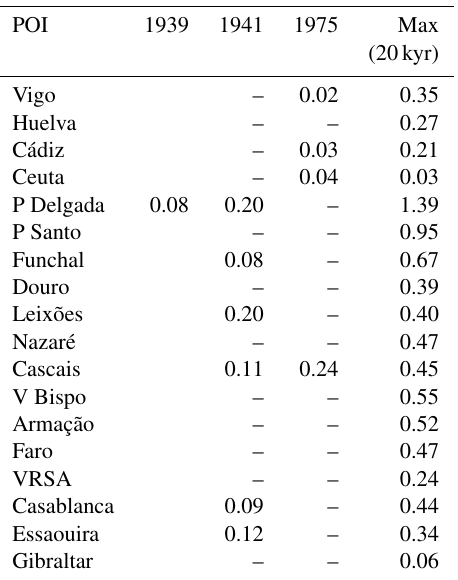
in the hazard curves by considering an appropriate time span for the synthetic catalogue. The size of the initial deforma- tion of the seafloor is dependent on the value of the